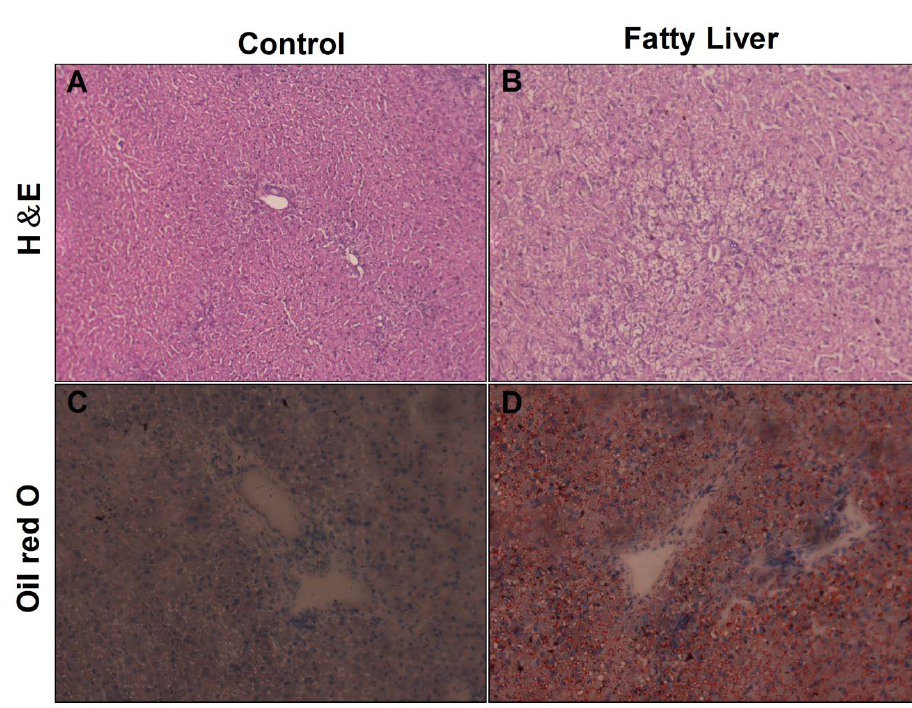
Figure 2. Assessment of hepatic histology in the liver of the control group and fatty liver group. ( A , B ) Hematoxylin and Eosin staining of liver sections from the control group and fatty liver group. Original magnification: 20 × ( C , D ) Liver sections were stained with Oil Red O and Hematoxylin stain for nuclei. Original magnification: 20 ×